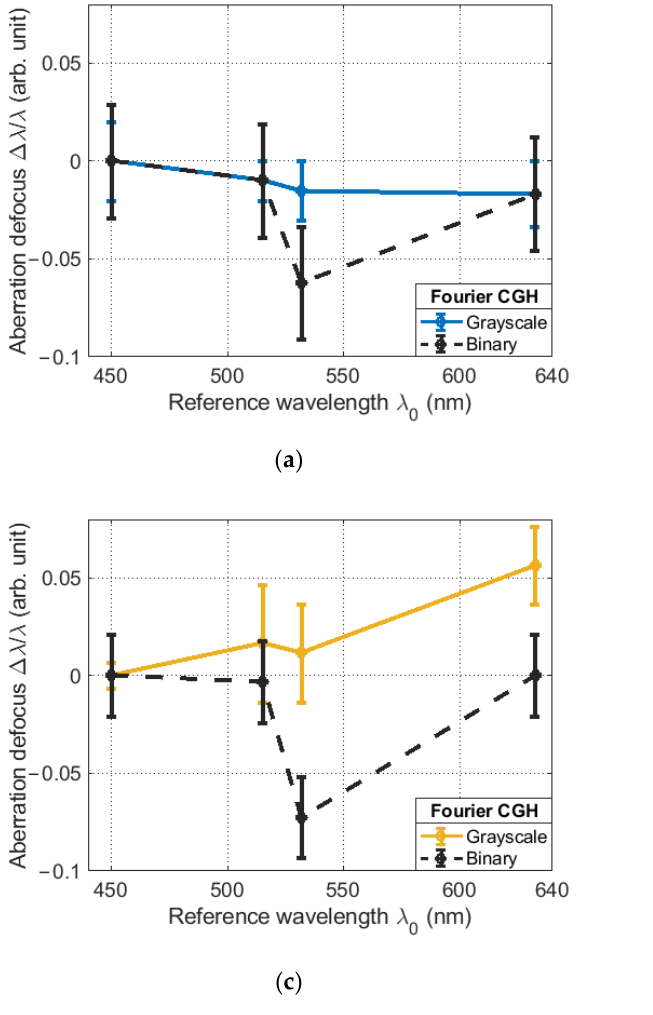
Figure 9. Deviation of the value of the weight coefficient of the Zernike polynomial as a function of the SLM tuning associated with the reference wavelength 𝜆 0 for sources with a wavelength: ( a ) 𝜆 1 = 473 nm; ( b ) 𝜆 2 = 532 nm; ( с ) 𝜆 3 = 561 nm; ( d ) the deviation of the position of the correlation response in the analysis plane.